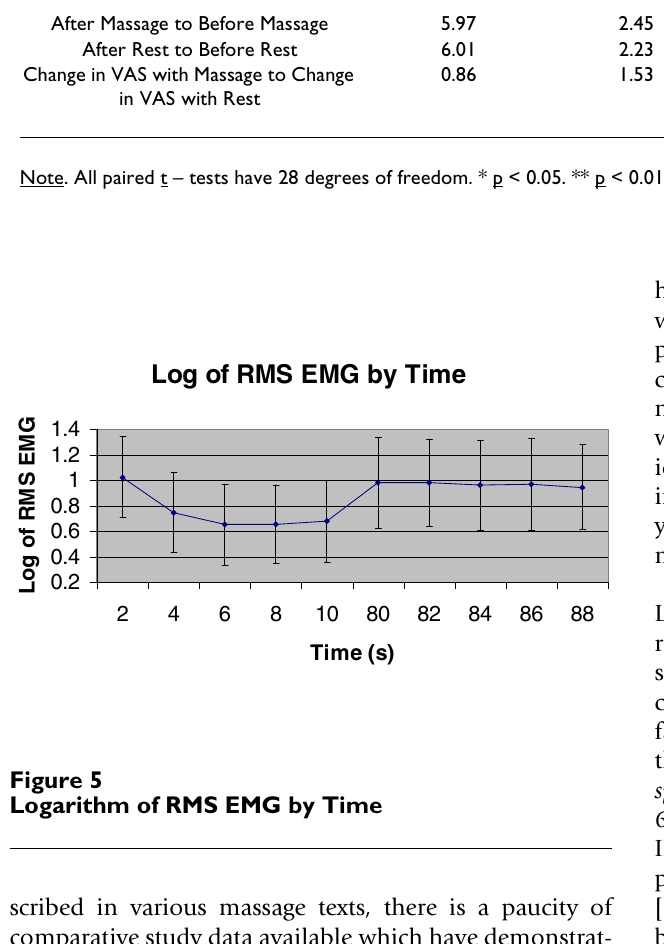
Figure 5 Logarithm of RMS EMG by Time